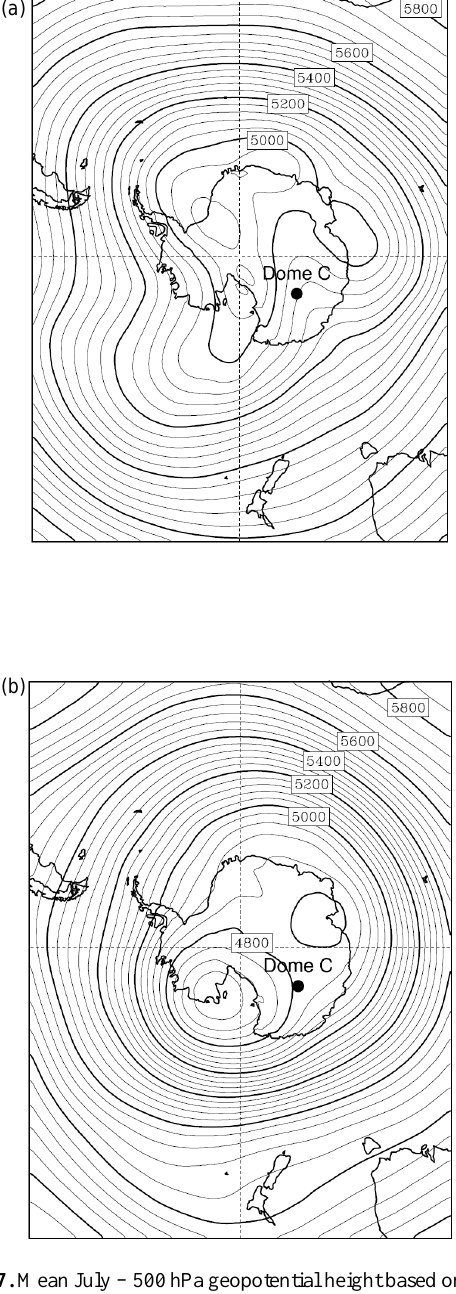
Figure 7. Mean July – 500hPa geopotential height based on AMPS archive model output for 2009 and 2010.